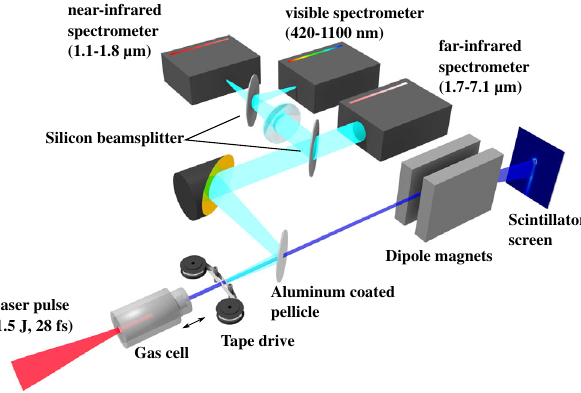
FIG. 1. Experimental setup: Accelerated electrons (dark blue) leaving the plasma generate coherent transition radiation (light blue) when they traverse the steel tapes. CTR from the 2nd tape is separated from the copropagating electron bunch, collimated by ¼ 190 . 5 mm), split by silicon wafers an off-axis paraboloid ( f eff and directed into 3 optical spectrometers covering a spectral range from 0 . 4 – 7 . 1 μ m. The electron beam energy and charge is analyzed by a pair of dipole magnets and a scintillating screen. Additionally a second scintillating screen (not shown) located in front of the magnets can be inserted to determine the beam divergence and transverse